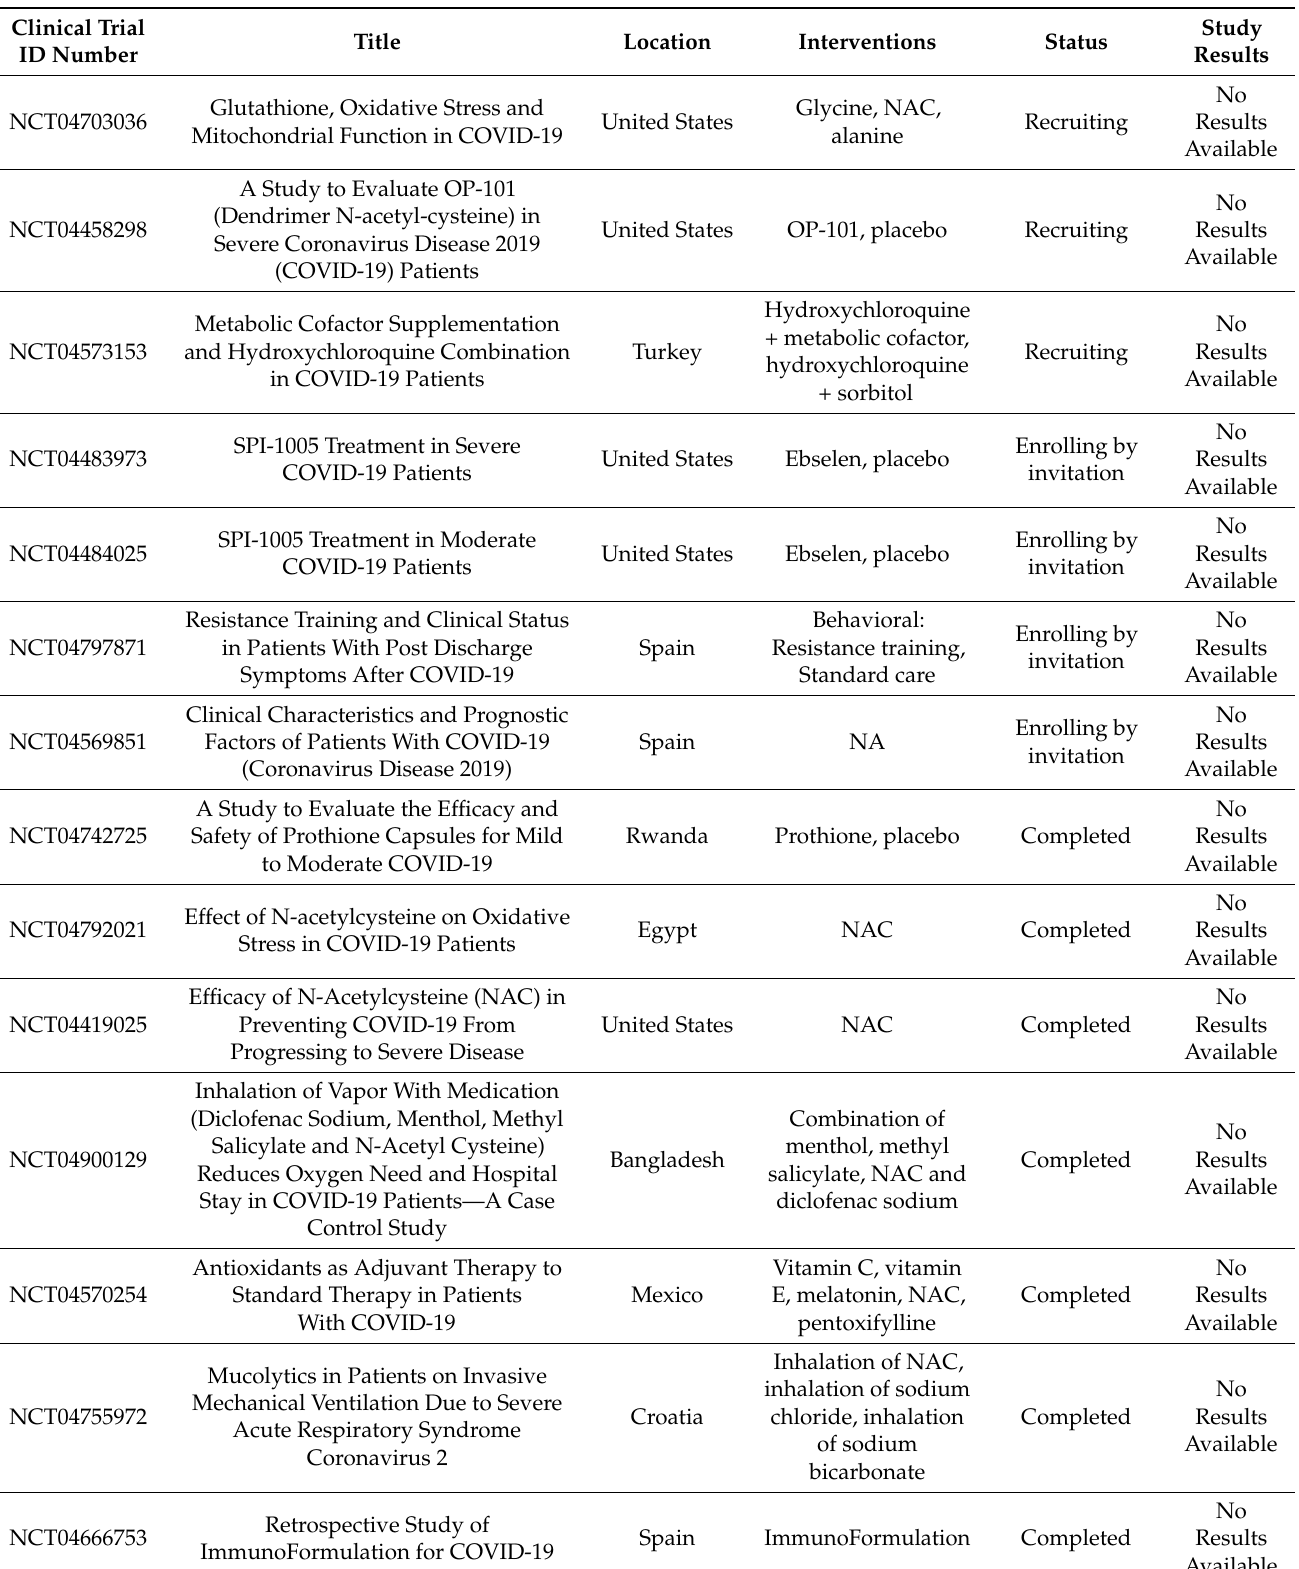
Table 7. Registered clinical trials on NAC or GSH supplementation in COVID-19 treatment that are recruiting patients or have been